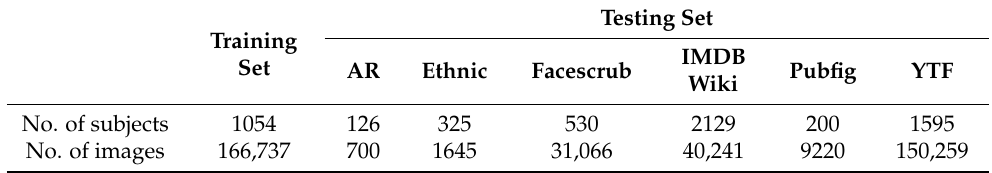
Table 1. Description of training and testing